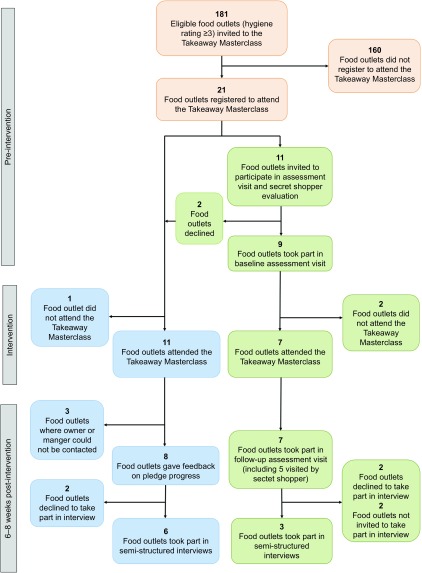
Takeaway Masterclass intervention and evaluation participation flowchart